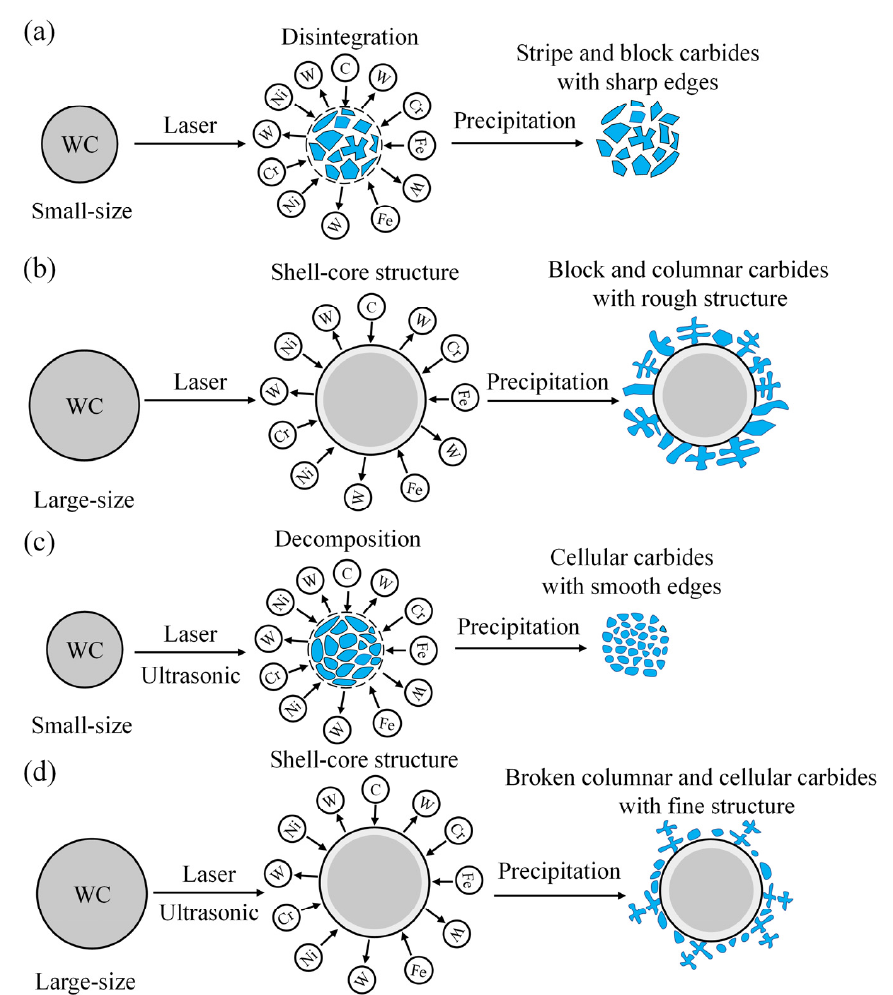
Figure 17. A schematic of grain refinement including small and large size WC particles in laser cladding: (a), (b) without ultrasonic vibration; (c), (d) with ultrasonic vibration.